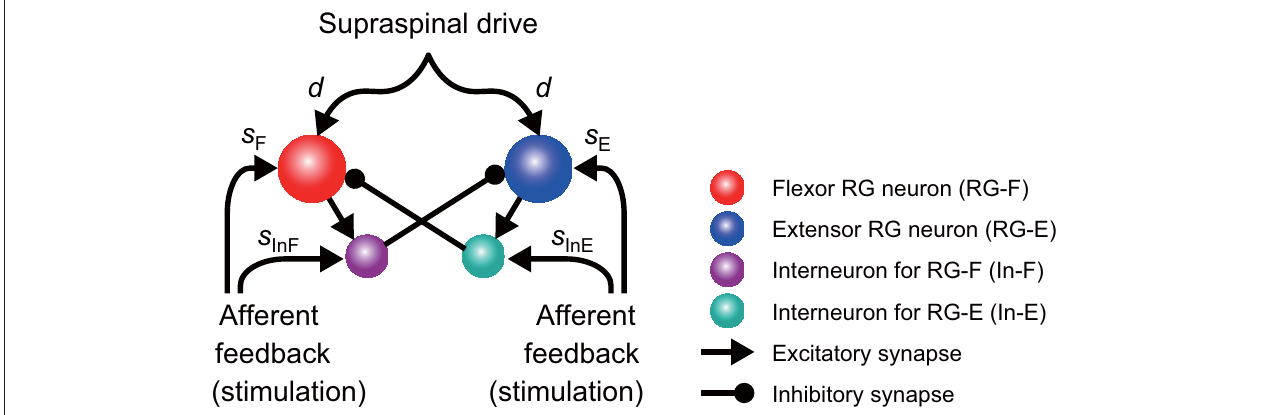
FIGURE 1 | Model schematic of the rhythm generator (RG) network and afferent inputs. The RG network is composed of flexor (RG-F) and extensor (RG-E) centers inhibiting each other via inhibitory interneurons In-F and In-E, respectively. The supraspinal drive provides excitation to the RG-F and RG-E neurons defining the frequency of oscillations. Sensory afferents can synaptically excite both RG neurons and inhibitory interneurons.